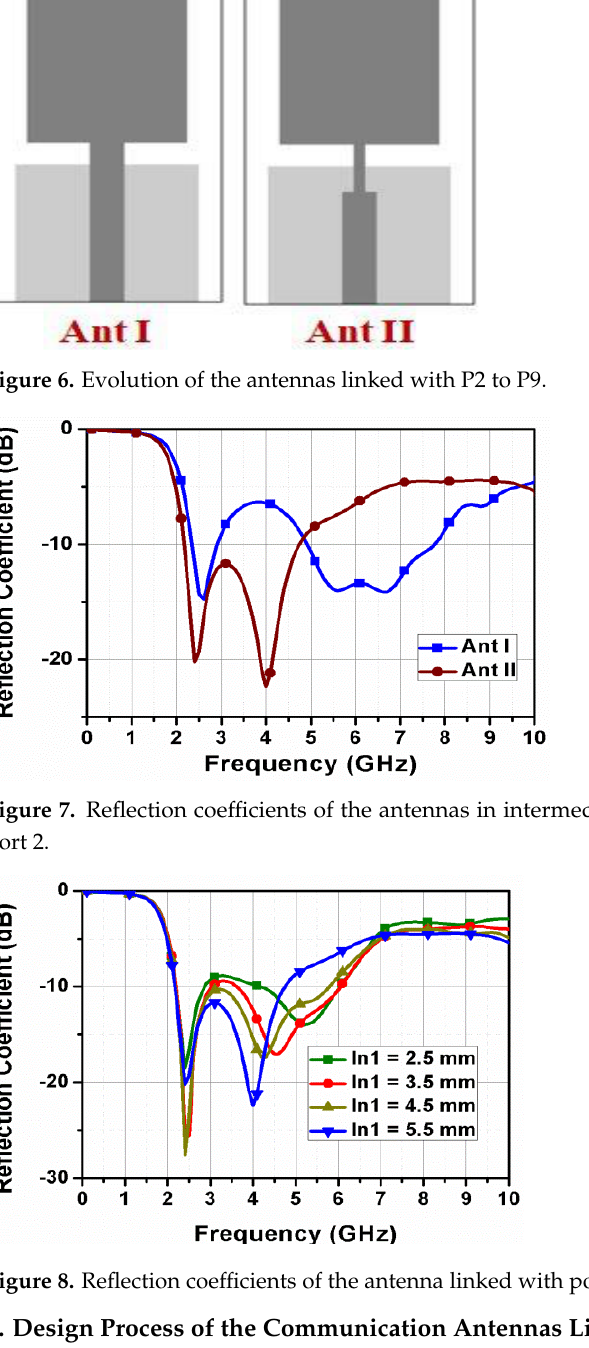
Figure 9. Schematic of the antennas linked with P10 to P17. The design process of the communication antenna linked with port 10 ends in two stages. In the first stage, a rectangular radiator of length 11.5 mm and width 9.5 mm is fed by a bent microstrip line feed, as depicted in Ant I in Figure 10. Furthermore, this antenna is realized with an 8-element MIMO configuration at ports P10 to P17. The mathematical formula for calculating the LBE of Ant I in Figure 10 is given below. 𝑓 𝐿 𝐴𝑛𝑡 𝐼 (𝑃10) =